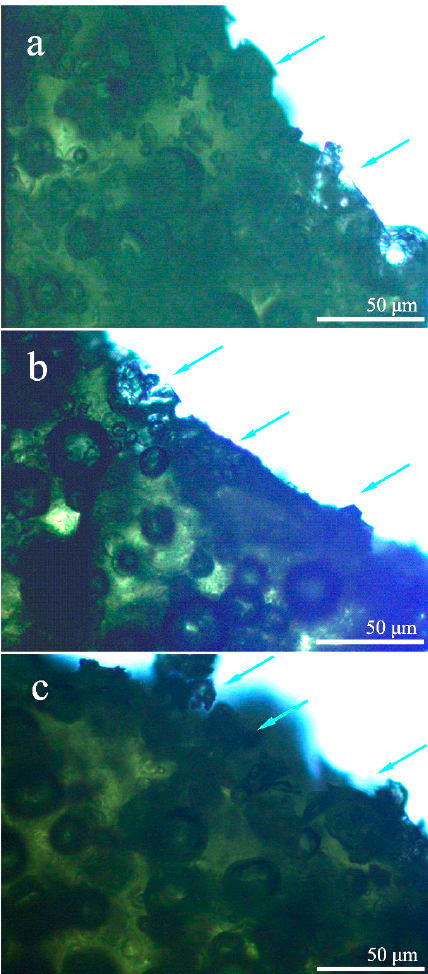
Figure 10. Morphologies of broken microcapsules on the surface of cracks under temperature of ( a ) 0 °C; ( b ) 10 °C; and ( c ) 20 °C. ( a ) 0 ˝ C; ( b ) 10 ˝ C; and ( c ) 20 ˝